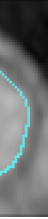
Figure 3. Final result (iteration 420), with the interpolation conditions (3 points) using Gout et al. algorithm [19].